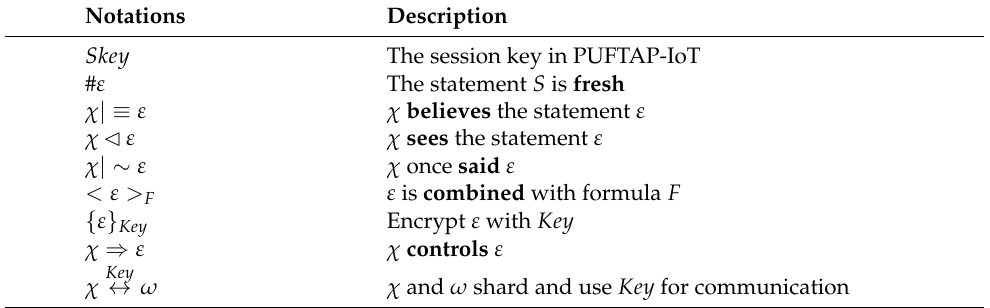
Table 2. The basic notations of BAN